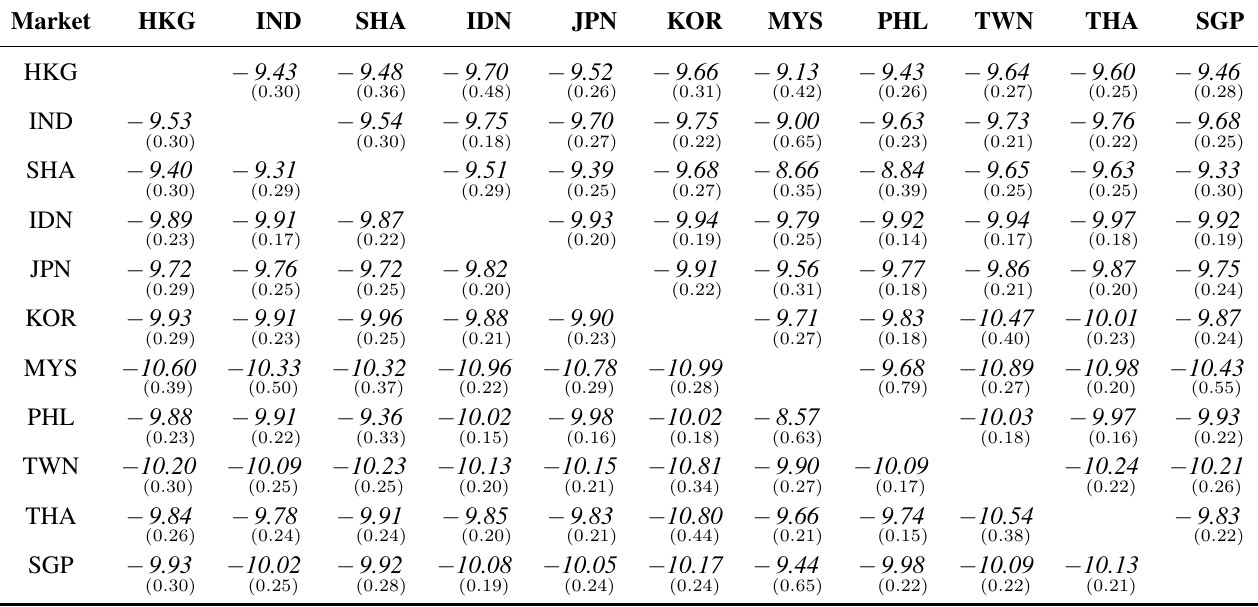
Table 8. Estimation results of  1 in the bivariate SV